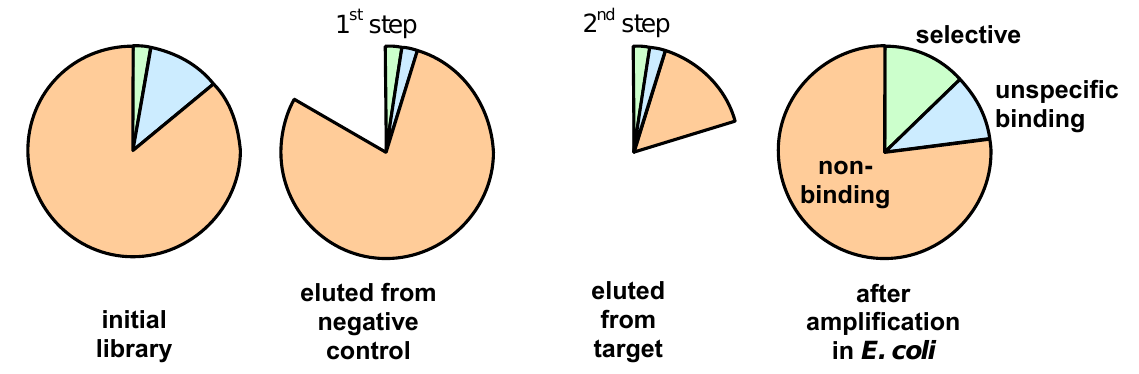
Figure 7. Schematic representation of the effect obtained by applying negative panning prior to the positive selection